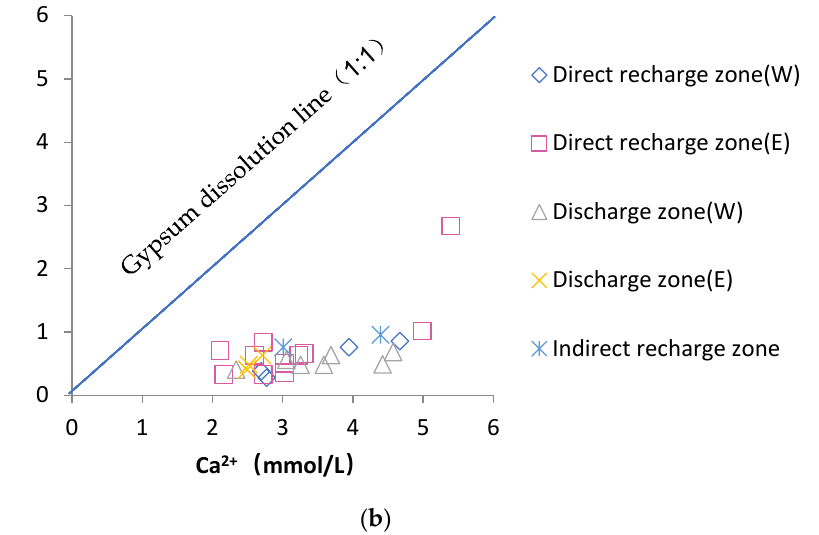
Figure 10. Correlation between the concentration of 3 H and major sulfate rock-related ions in karst water . ( a ) Correlation between the concentration of 3 H and SO 4 2− ; ( b ) Correlation between the concentration of Ca 2+ and SO 4 2− .